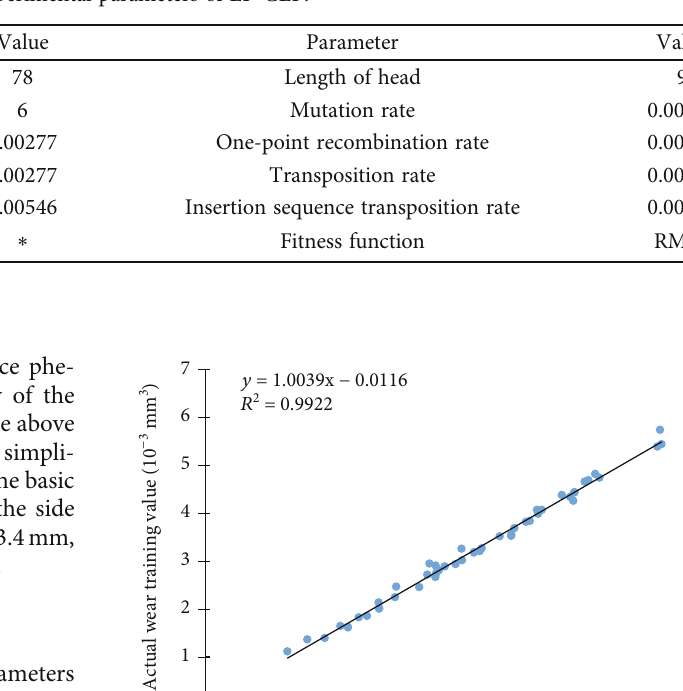
Table 2: Experimental parameters of